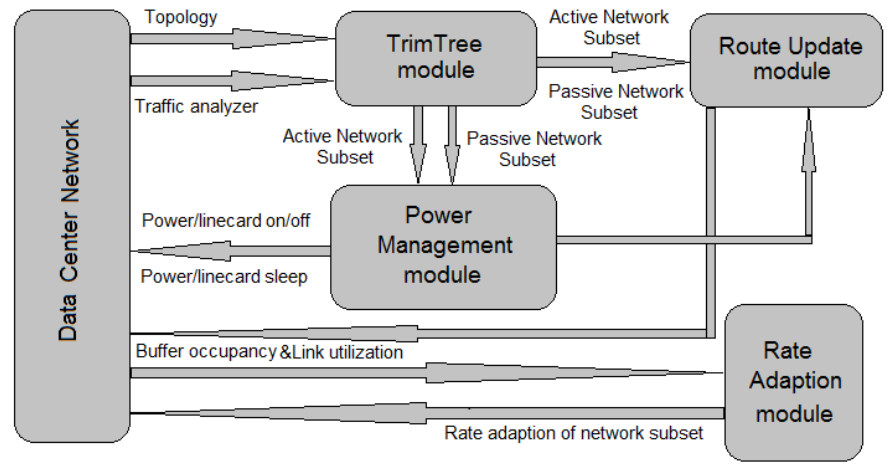
Figure 1. System design of Adaptive TrimTree mechanism.